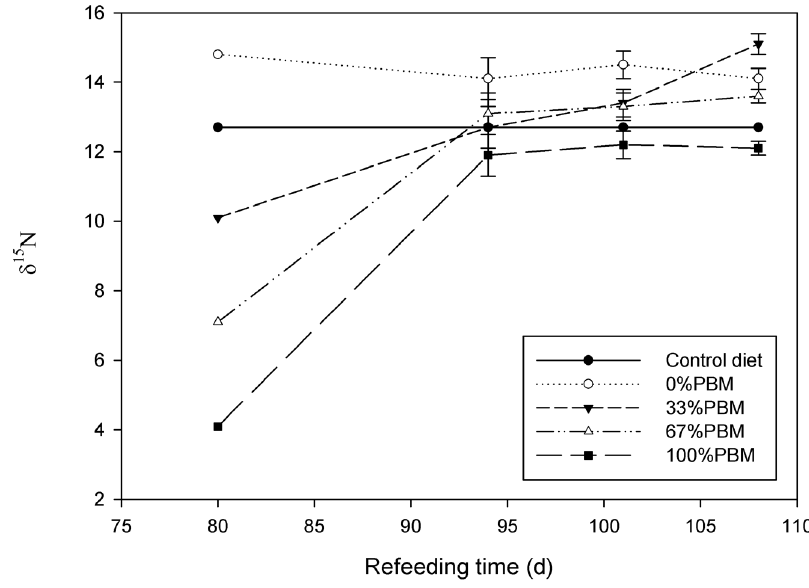
Figure 1. Isotopic values ( d 15 N; % ) of rainbow trout ( Oncorhynchusmykiss ) muscle tissue that were isotopically equilibrated into four experimental diets with different levels of substitution of fishmeal with poultry by-product meal (time 0) and were then switched to the control diet and fed for a 28 additional days. PBM: Poultry by product meal. Values shown are means (n=3) 6 SD.